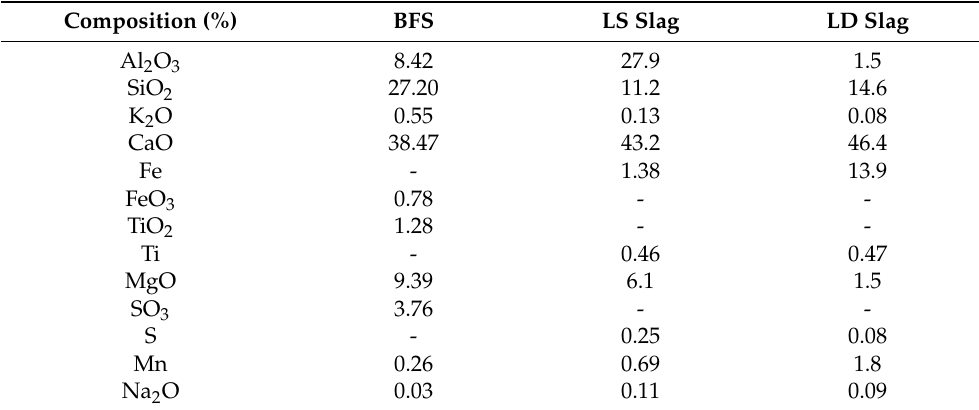
Table 1. X-ray fluorescence (XRF) results of raw materials blast furnace slag (BFS), ladle slag (LS), and Lintz–Donawitz converter slag